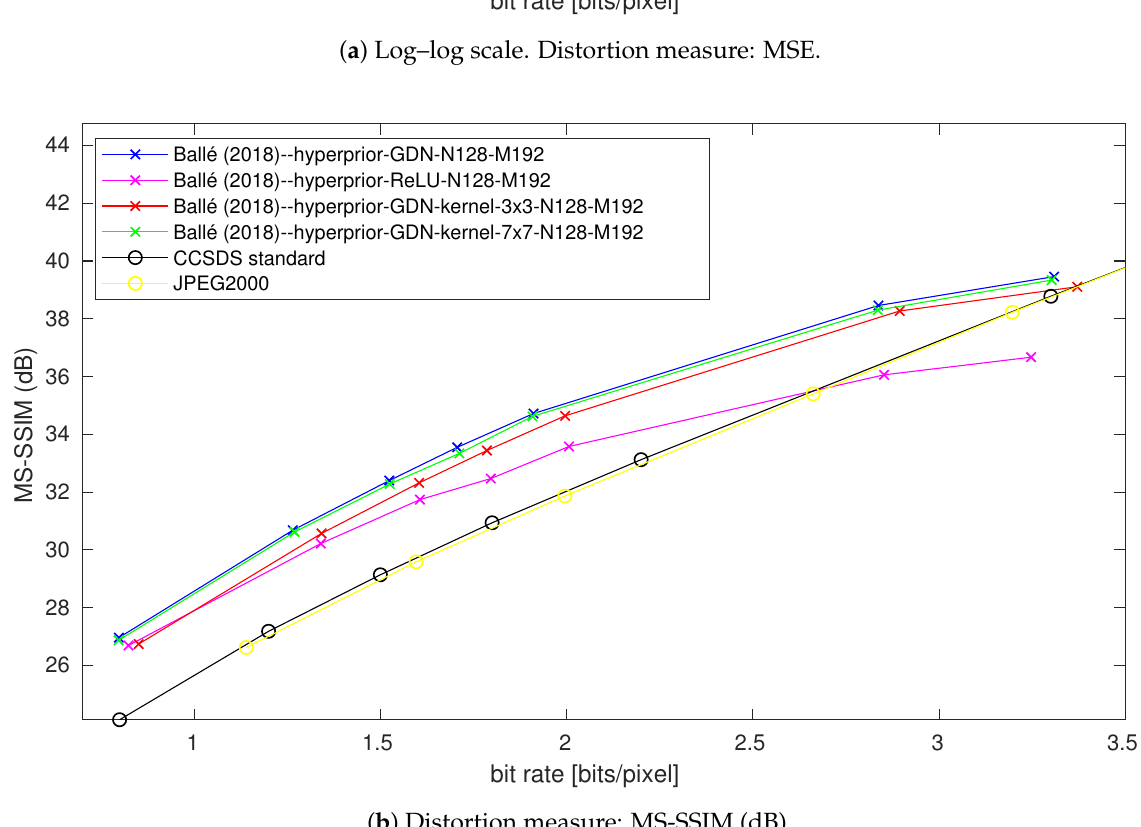
Figure 13. Impact of the GDN/IGDN replacement and of the filter kernel support on performance in terms of MSE and MS-SSIM (dB) (derived as − 10log (1 − 10